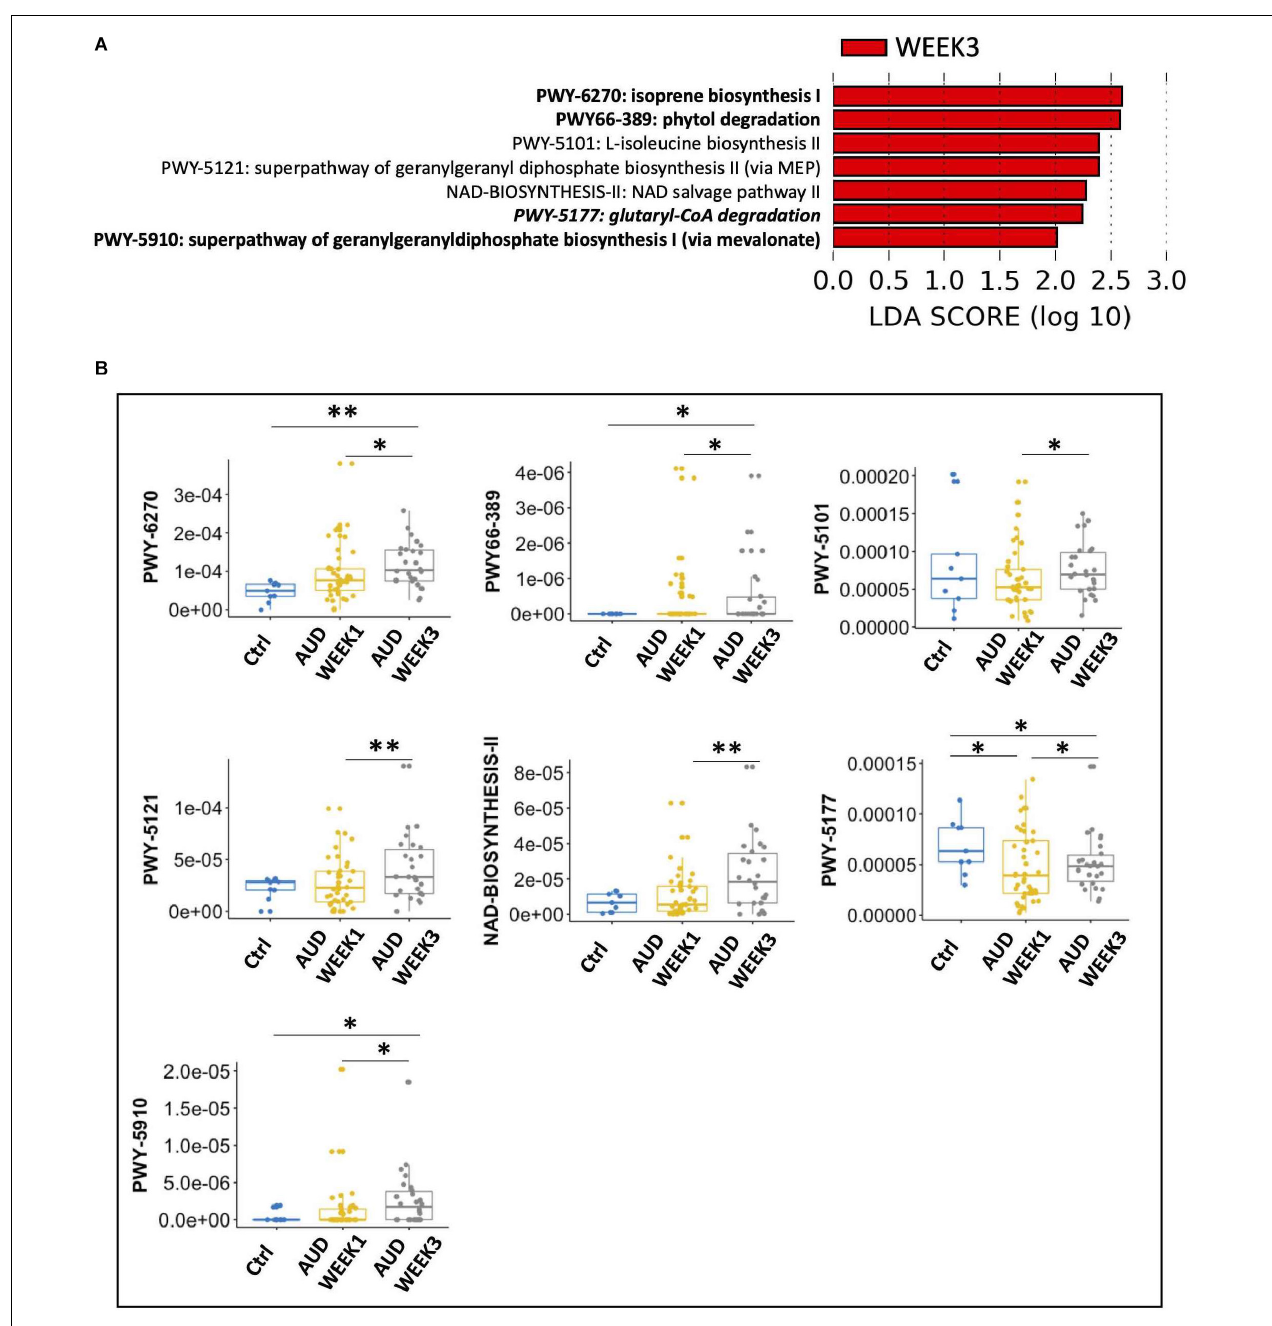
FIGURE 1 | Seven sensitive microbial pathways to alcohol abstinence in alcohol use disorder patients. (A) Seven microbial pathways were enriched at WEEK 3 compared with WEEK 1. Italic: significantly altered pathway comparing control subjects and alcohol use disorder patients at WEEK 1. Bold: significantly altered pathways comparing control subjects and alcohol use disorder patients at WEEK 3. (B) Pairwise comparison of control subjects, alcohol use disorder patients at WEEK 1 and alcohol use disorder patients at WEEK 3. ∗ : p -value < 0.05; ∗∗ : p -value < 0.01.